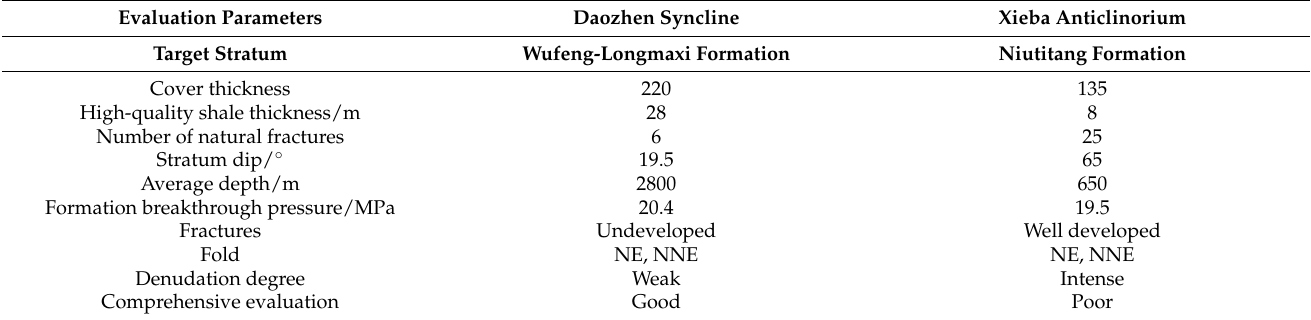
Table 11. Comprehensive evaluation of the tectonic preservation conditions of the Wufeng-Longmaxi and Niutitang Formations in northern Guizhou